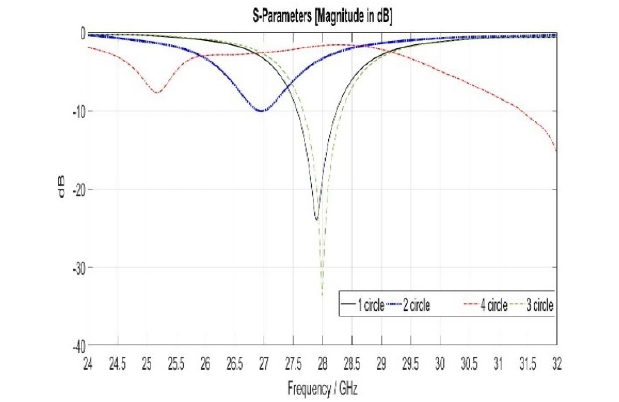
Fig 5. Return loss variations of antenna in different aperture